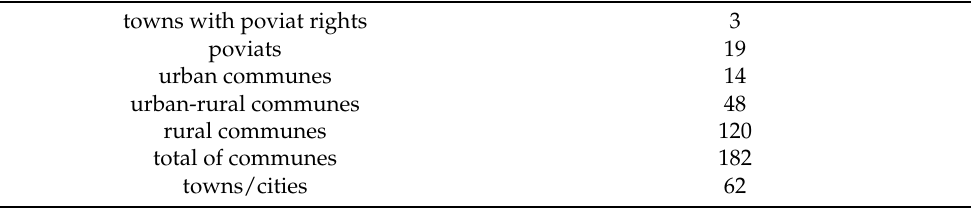
Table 1. Administrative division of the Małopolskie Voivodeship. towns with poviat rights 3 poviats 19 urban